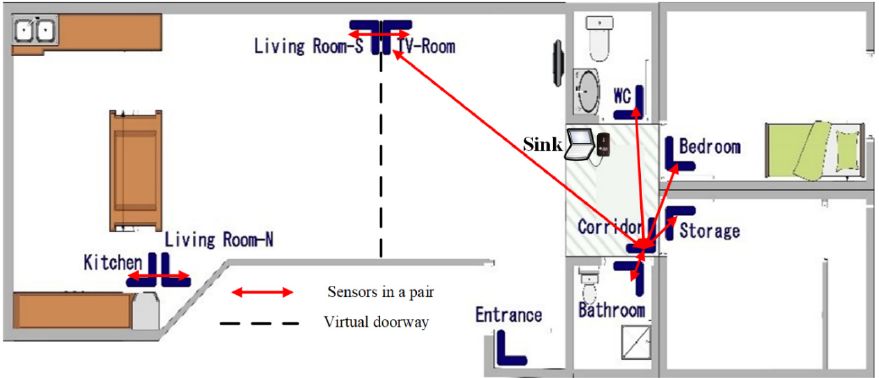
Figure 5. Positioning of PIR sensors and sink node in testbed for deployment phase.